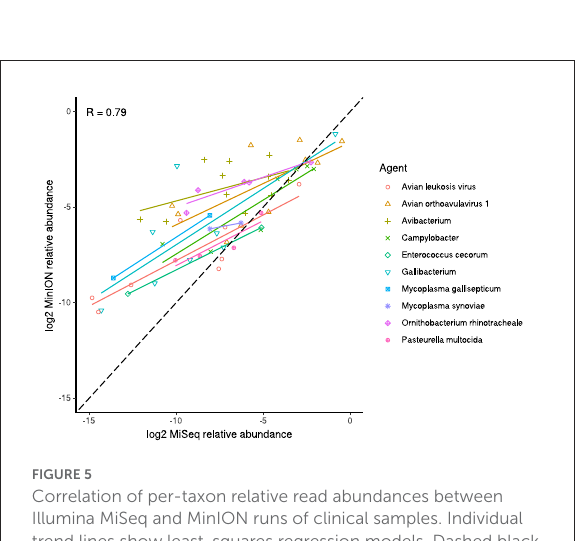
FIGURE3 Correlation of per-taxon relative read abundances between Illumina MiSeq and MinION runs. Individual trend lines show least-squares regression models. Dashed black line indicates the identity (1:1) relationship. Data used was from experimental and clinical samples. Pearson’s R value is calculated from the combined dataset.